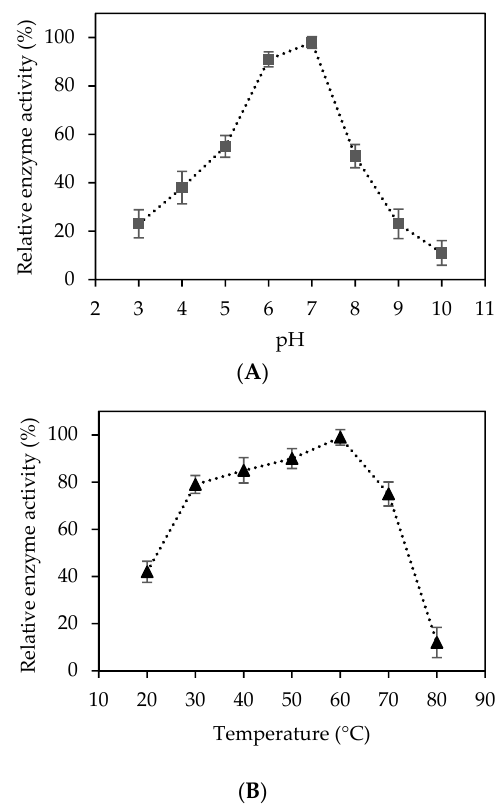
Figure 3. Relative cellulase activity analysis of various pH and temperature conditions. ( A ) Enzymatic hydrolysis of 0.5% CMC was carried out at 50 °C for 3 h with an agitation of 200 rpm; ( B ) Enzymatic hydrolysis of 0.5% CMC was carried out at pH 7.0 for 3 h with an agitation of 200 rpm. Error bars indicate the standard deviation of triplicated tests.